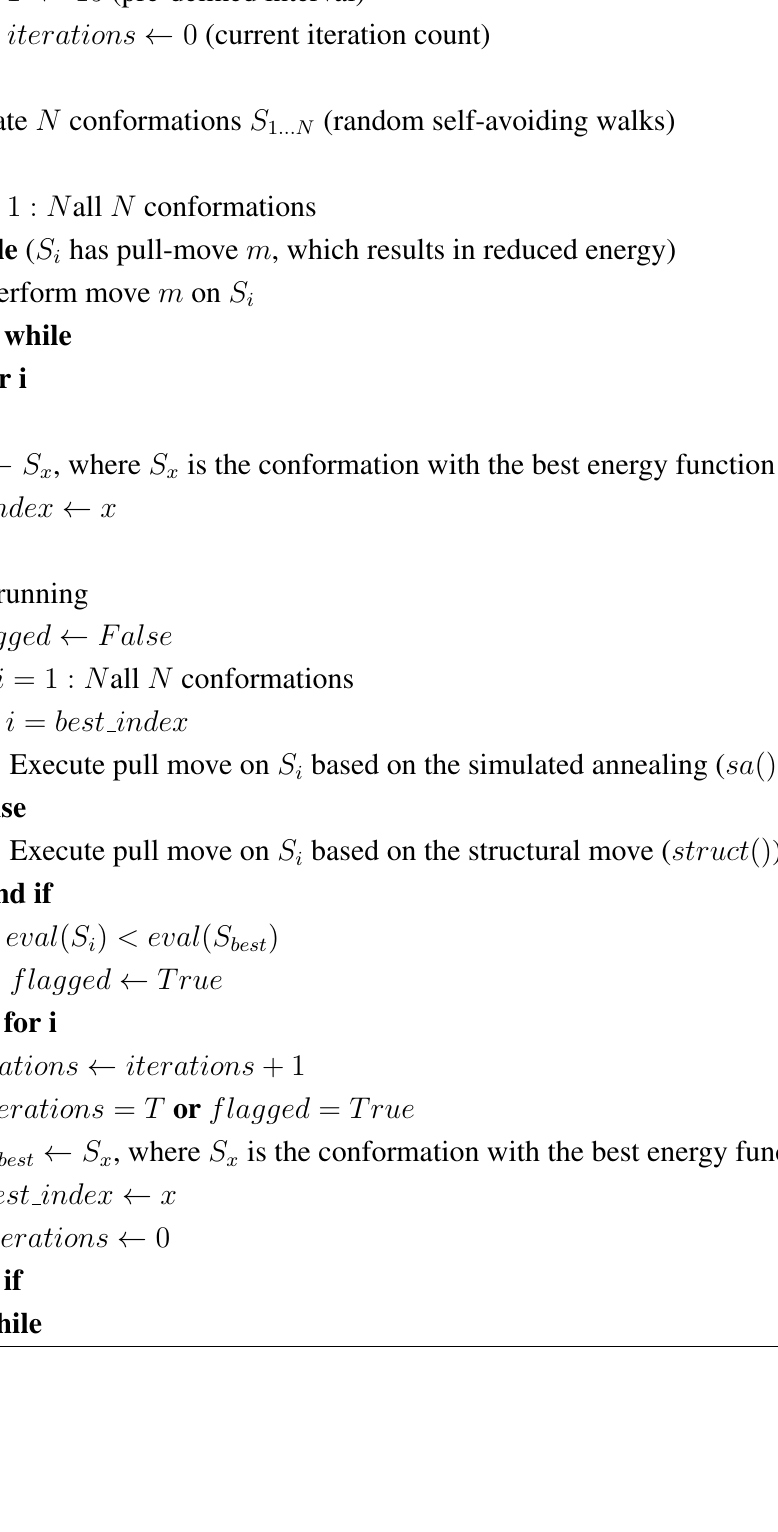
Figure 2. Pseudocode of the integration of the Firefly Algorithm and local